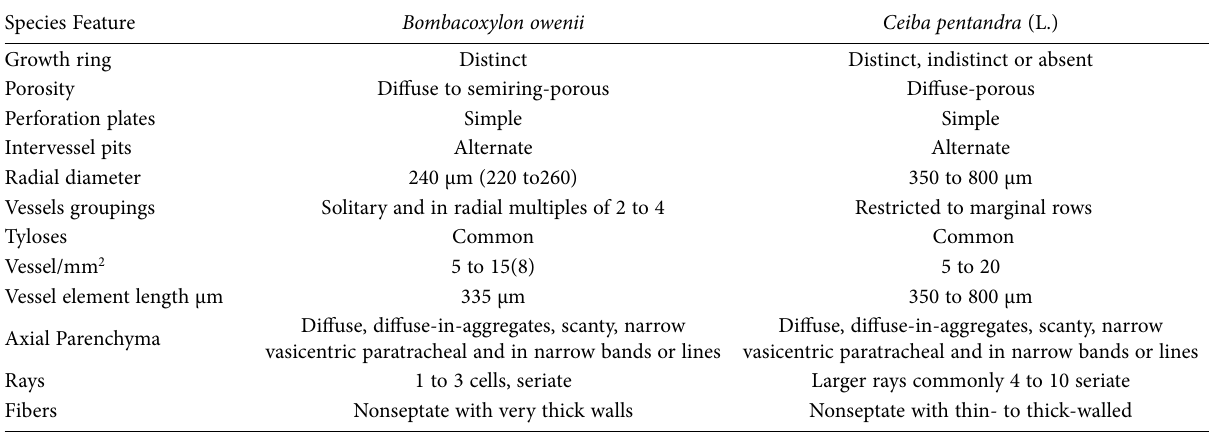
Table 8. Comparison of anatomical features between Bombacoxylon owenii & Ceiba pentandra